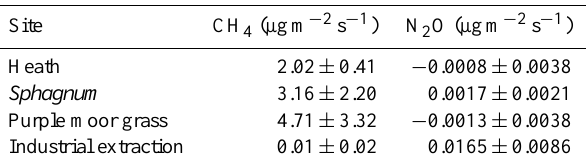
Table 3. Mean annual CH 4 and N 2 O fluxes ± SD at four different bog sites. Values refer to means of four replicates ±